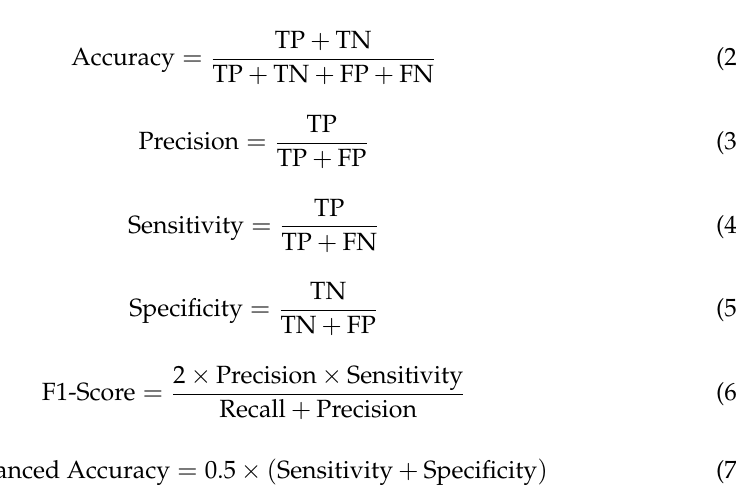
Table 2. The different hyperparameters used in the current investigation and their various